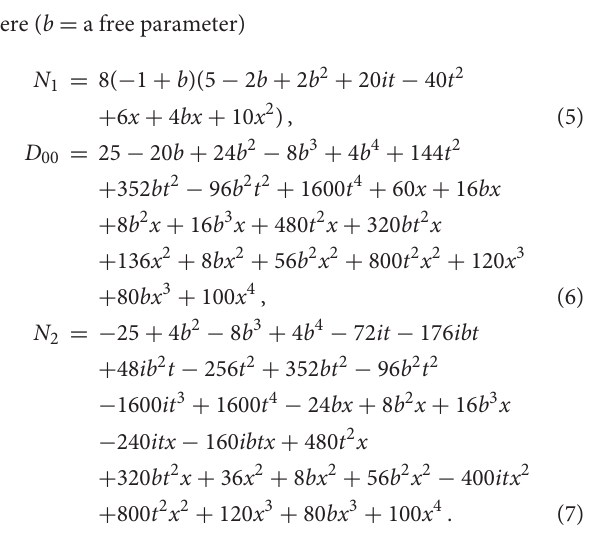
FIGURE 2 | Planar plot of the wave intensity | A | 2 in physical space vs. the spatial coordinate x for one particular instant in time t , Equation (4) through Equation (7), b = 1.5. The maximum height occurs at the spatial location of x = − 0.600.